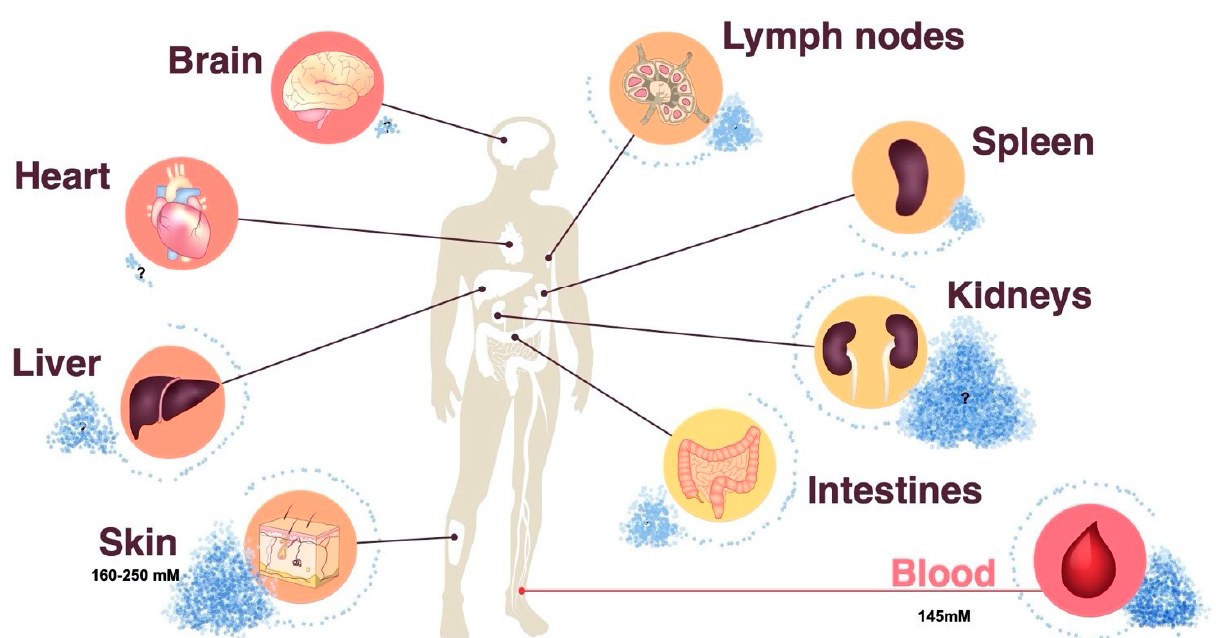
Figure 1. Differential distribution of sodium chloride in human organs. The skin can dynamically store sodium chloride, and thus exceed systemic sodium chloride concentrations in the peripheral blood. Dietary salt intake contributes to sodium chloride accumulation in the skin and possibly other peripheral organs. Neutron activation analysis represents a very sensitive method for the quantification of tissue sodium chloride concentrations. Question marks indicate that sodium chloride concentrations in the indicated organs remain to be established.